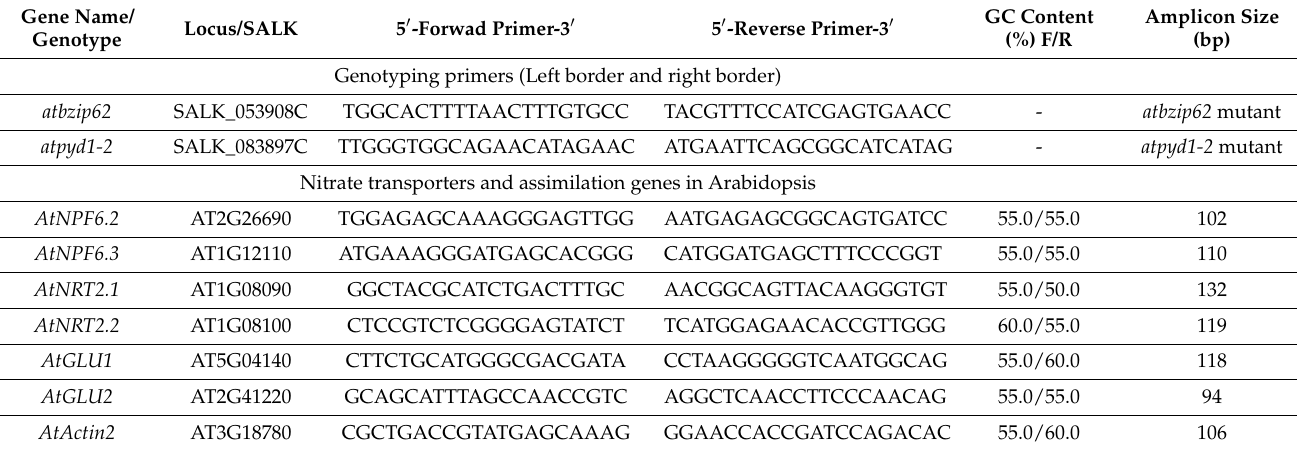
Table 3. Arabidopsis mutant lines and set of qPCR primers for the expression of target genes used in the study. Gene Name/